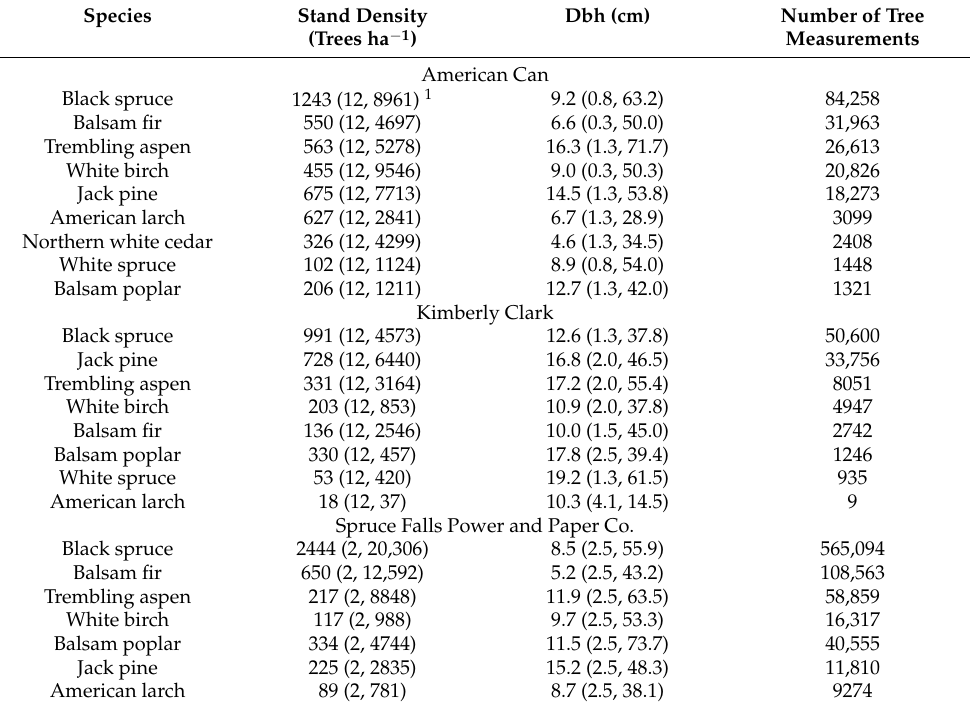
Table 2. Basic statistics (mean and range) of stand density and diameter at breast height (dbh) and number of tree measurements for data sets in the boreal forest of northern Ontario.